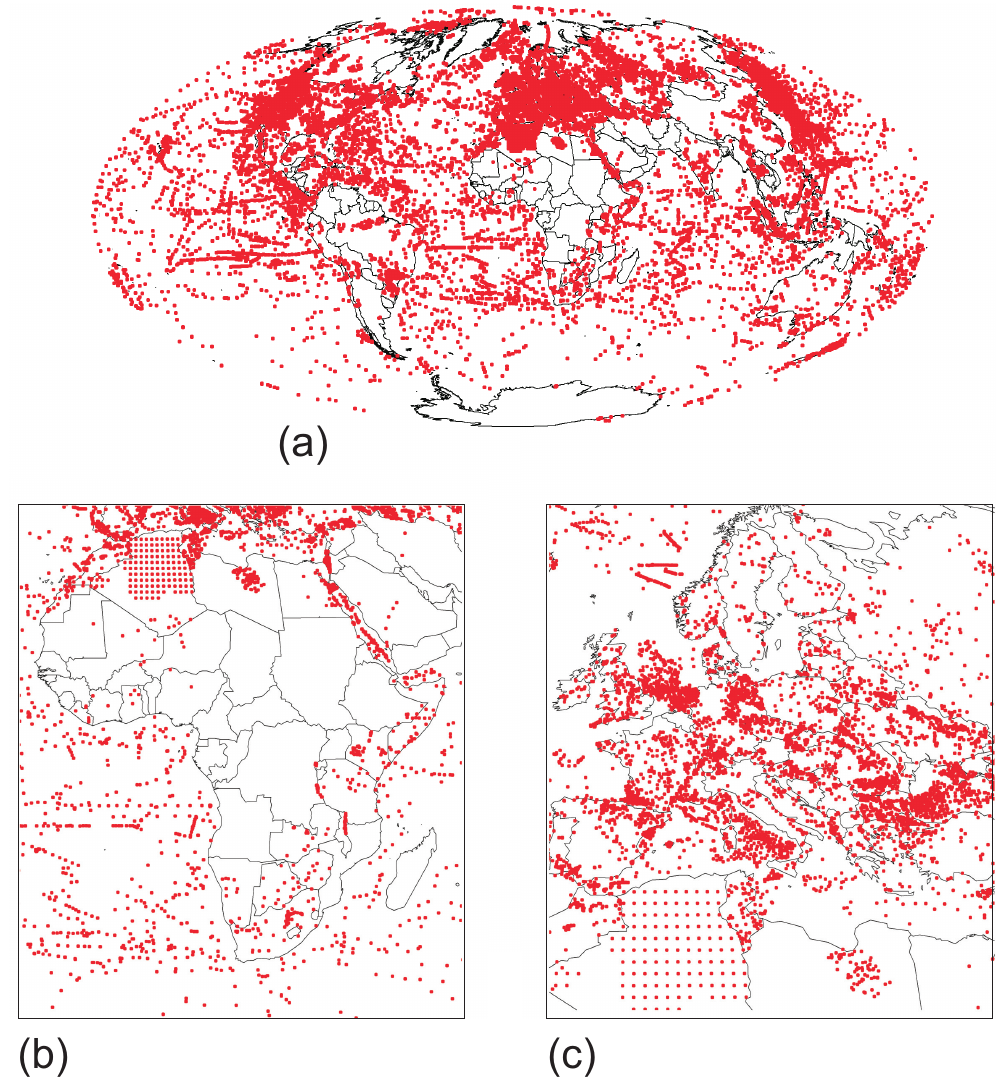
Fig. 1. (a) Global distribution of heat flow measurements, showing the inhomogeneous distribution of data-points. This suggests that extrapolations to develop a global heat flux estimate might benefit from utilising any global indicator that might be correlated with heat flow. In this study, we use geology for this purpose, following the work of Pollack et al. (1993). (b) Focussed on the African continent – note the sparsity of data points. (c) Focussed on Europe, where good coverage is apparent, particularly in areas such as the Central North Sea, Black Sea and Tyrrhenian Sea, where interest in surface heat flow has been extensive due to exploration and tectonism.